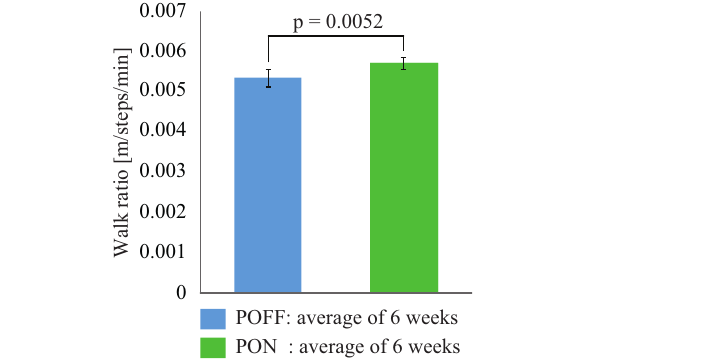
Figure 10. Comparison of the average walk ratio between the POFF condition and the PON condition. On each bar chart, the error bar denotes one standard